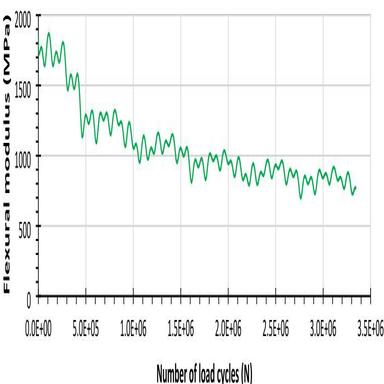
Simulated results of strain-controlled modulus degradation for temperature variation shown in.